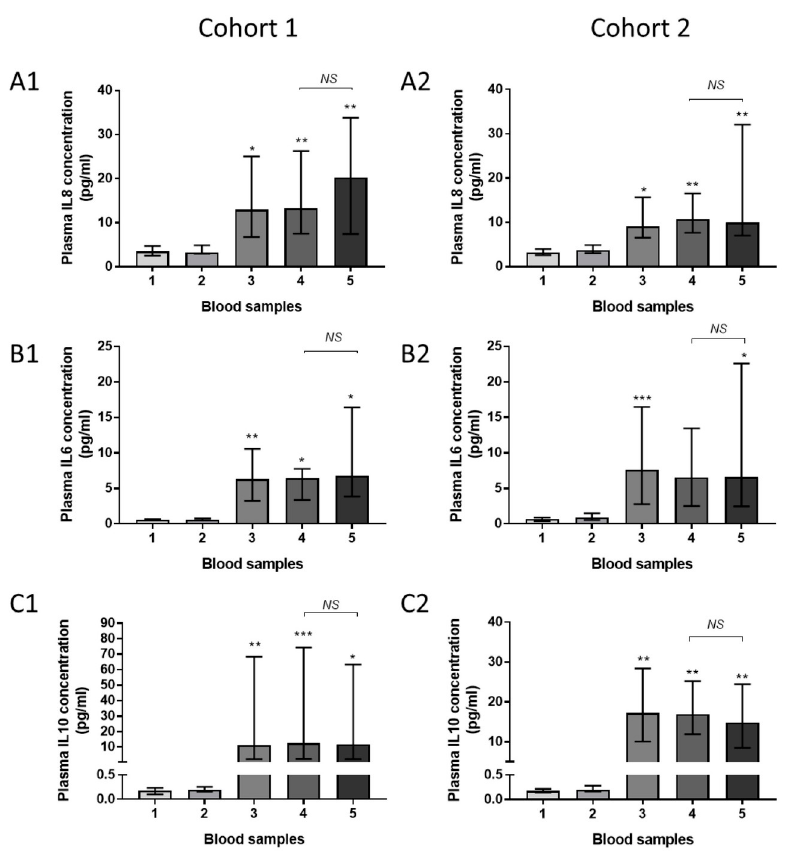
Fig 4. Plasma cytokines. Data are presented as median (columns) and interquartile range (bars). Left-sided graphs represent cohort 1, right-sided cohort 2. [A1,2] IL-8, [B1, 2] IL-6 and [C1,2] IL-10. The Friedman test with Dunn’s post-hoc multiple comparisons compared values between the sample 1 and samples 2–5. Wilcoxon’s matched pairs signed rank test compared samples 4 and 5. � p < 0.05, �� p < 0.005, ��� p < 0.001. Abbreviations NS: non-significant (Cohort 1: n = 8 Cohort 2: n =